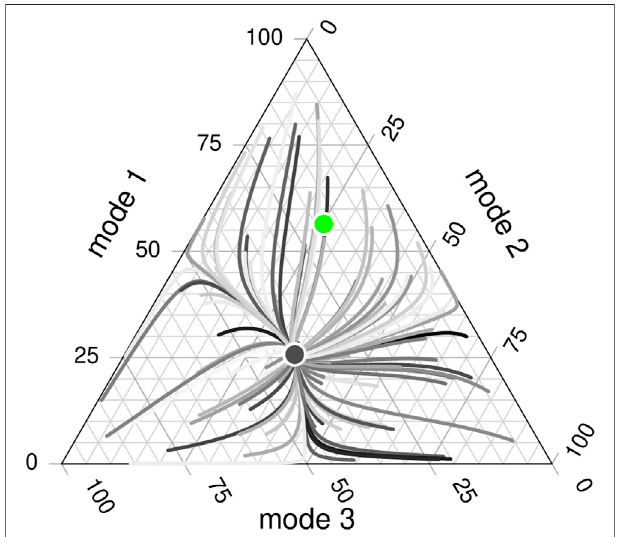
FIGURE2 | Each point in thetrianglerepresentsthe distribution ofusers among the three modes of transport. The triangle representation is such that atanypointinsidethesimplex X N ,thenumberofusersofallmodesrepresents the total population. For some point inside the triangle, the amount of users of mode 1 can be identi fi ed by following a horizontal line from the left axis. For mode 2, a diagonal line to the lower-left, and for mode 3, a diagonal line to the upper-left. The corners represent modal shares where all users use the same transport system. There is a commuting time associated with each transport mode and an average commuting time for each point. Different trajectoriesofthemodal-sharedynamicsareobservedascurveswithdifferent (randomly picked) colours across the simplex. Each curve starts at some randomly picked distribution, and eventually, all curves converge to the same point (the black disc), which is the attractor node and the Nash equilibrium for the dynamics, x ° . From all modal shares, there is one con fi guration which has the lowest average commuting times (the green disc), x + .